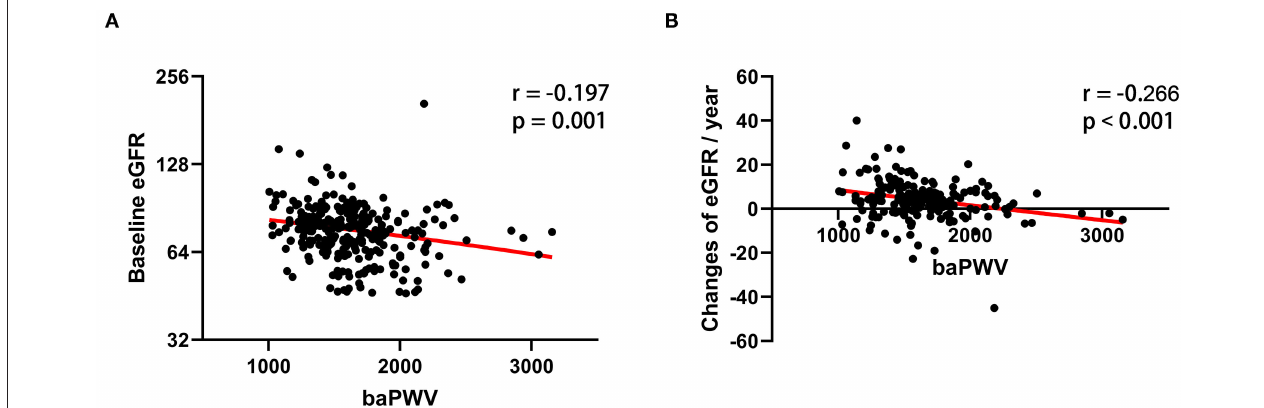
FIGURE 1 | Scatter plot of the relationship between baPWV and (A) baseline eGFR and (B) annual changes in eGFR. The red line represents the regression line.